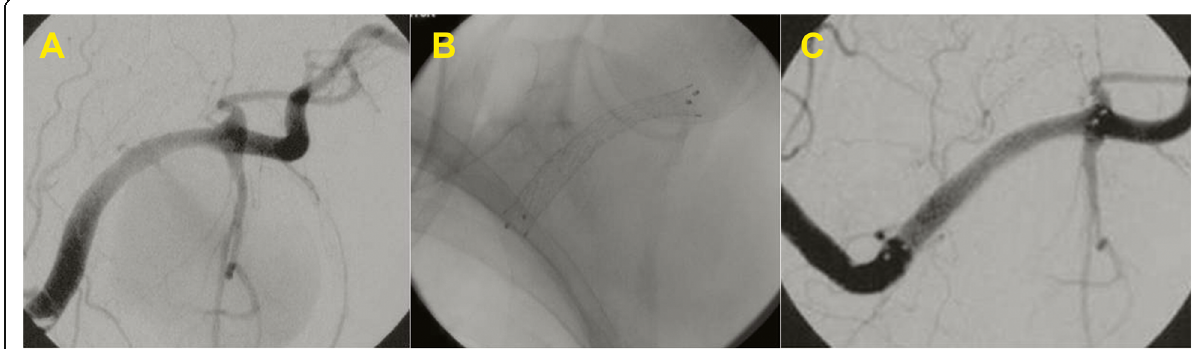
Fig. 2 a-c Pseudoaneurysm (PSA) treated with a stent-graft. Massive iatrogenic axillary artery PSA: a angiography shows the small tract through the arterial wall which feeds the PSA. b Placement of a covered stent along the axillary artery; c control angiogram after procedure